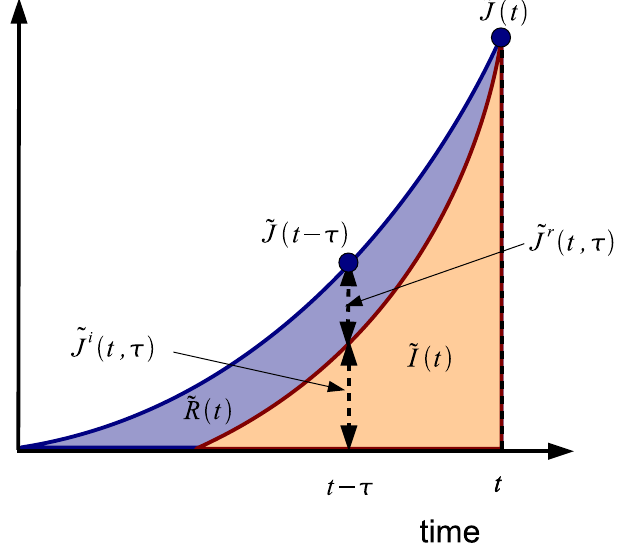
~ J ð t Þ (blue curve), on its past values. ~ J ð t (cid:2) (cid:2) Þ (cid:3)t , ~ J i ð (cid:2);t Þ (cid:3)t ¼ ~ J ð t (cid:2) (cid:2) Þ (cid:3)t (cid:1) ð (cid:2) Þ ~ J r ð (cid:2); t Þ (cid:3)t ¼ ~ J ð t (cid:2) (cid:2) Þ (cid:3)t ½ 1 (cid:2) (cid:1) ð (cid:2) Þ(cid:3) , have